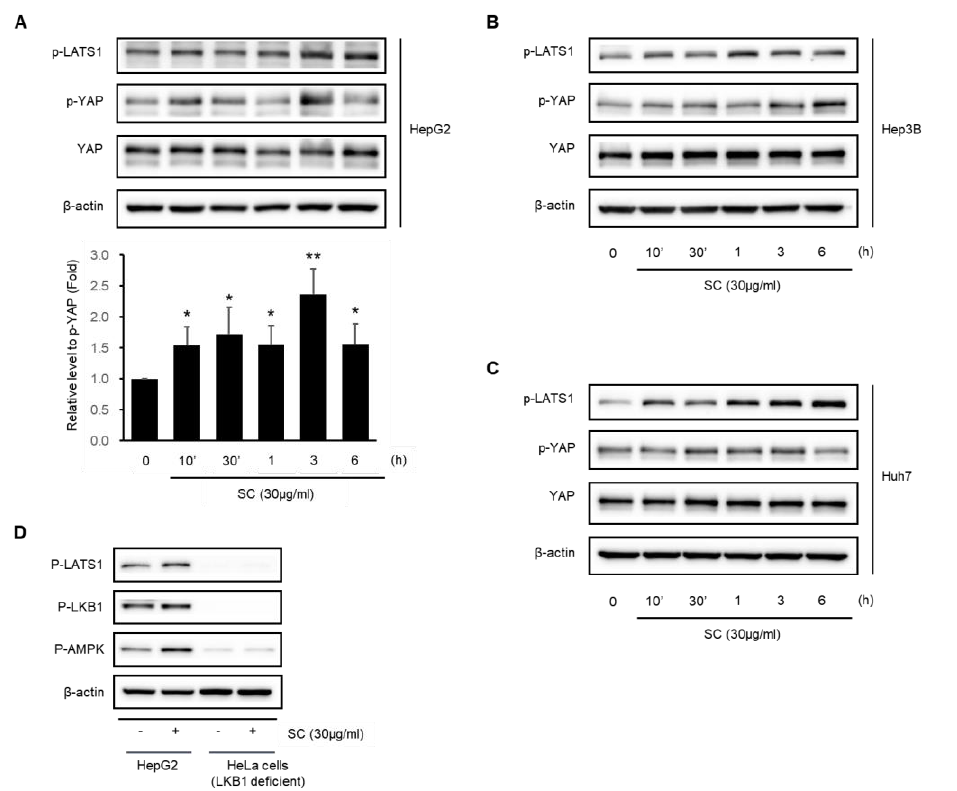
Figure 5. Effects of SC on YAP activation. Immunoblotting analysis of YAP-associated proteins was performed with HepG2 ( A ); Hep3B ( B ); and Huh-7 ( C ) cell lysates. The lysates of cells progressed as described in Figure 3. Expression of p-YAP in HepG2 represents the mean ± SD (* p < 0.05, ** p < 0.01 between the control and SC-treated cells). ( D ) Comparison of p-LATS1, p-LKB1, and p-AMPK expression in LKB1-deficient HeLa and HepG2 cells. The cells were incubated as in Figure 3 and treated with 30 μg/mL SC for 1 h.